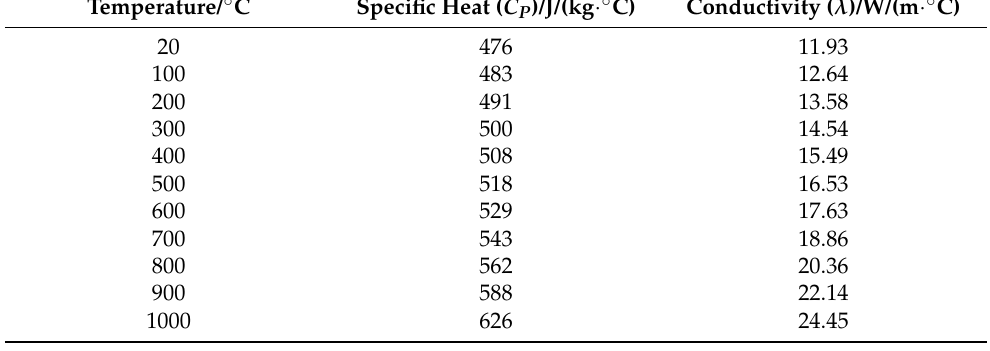
Figure 1. Physical model of impingement cooling of the high-temperature steel tube via inclined jet. Table 1. Thermophysical parameters of the 304 austenitic stainless steel.